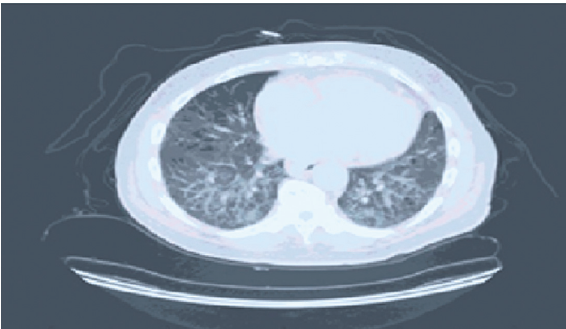
Figure 1: CT chest with contrast showing bilateral interlobular septal thickening, multiple ground-glass opacities, and cystic changes.